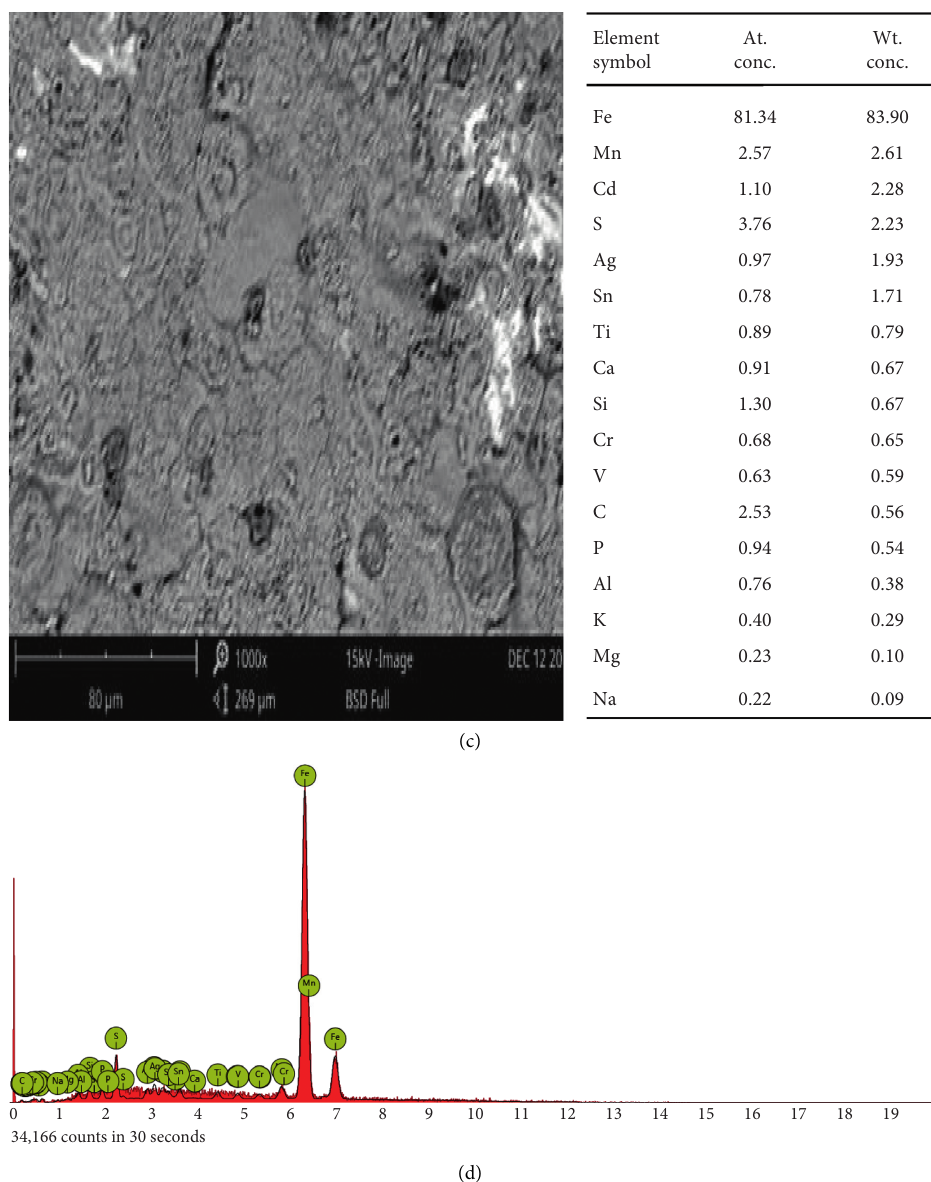
Figure 9: SEM micrograph of mild steel coupon with the EDX analysis data after 4 days immersion in H containing 1.5 g of MBZ. EDX spectra of mild steel coupon after 4 days immersion in a 1.5M H 2 SO 4 solution containing 1.5 g of MBZ